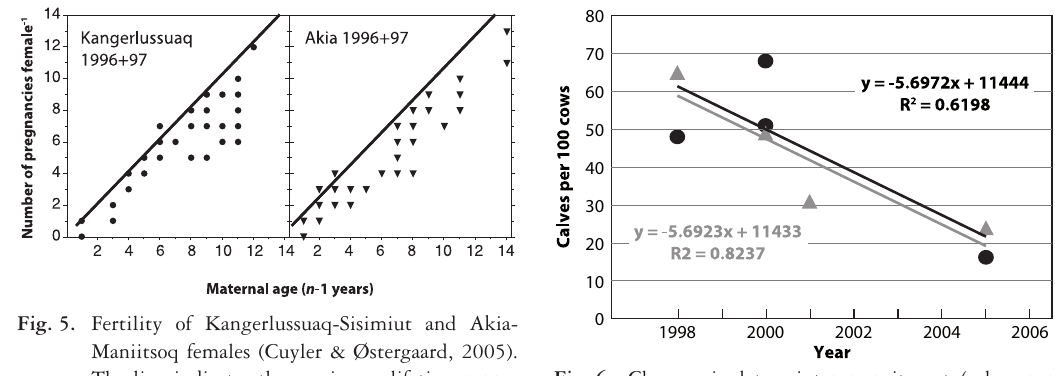
Fig. 6. Changes in late winter recruitment (calves per 100 cows) in two West Greenland herds, Kangerlussuaq-Sisimiut stock ( ● , — , P = 0.21), and Akia-Maniitsoq stock ( ▲ , — , P = 0.092); linear regression lines with R 2